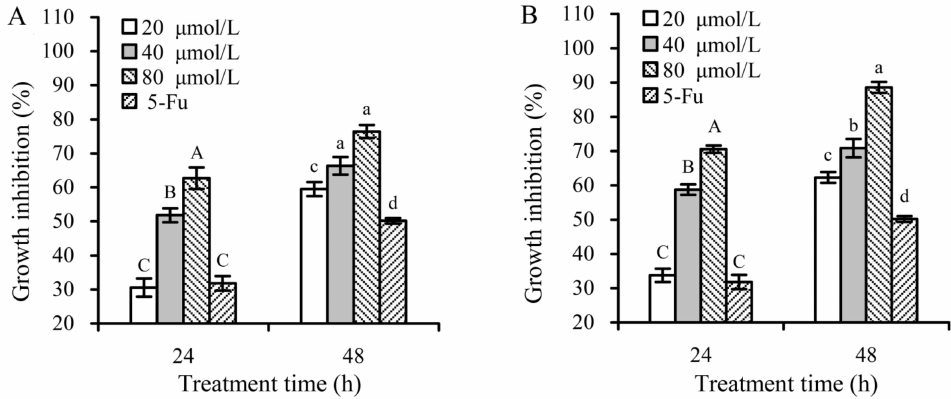
Figure 3. Growth inhibition of apigenin ( A ) and luteolin ( B ) of various concentrations on the Hela cells at treatment times of 24 and 48 h. 5-Fu, 5-fluorouracil as a positive control. Di ff erent capital or lowercase letters above the columns indicate that the means within the same group di ff er significantly according to one-way ANOVA ( p <